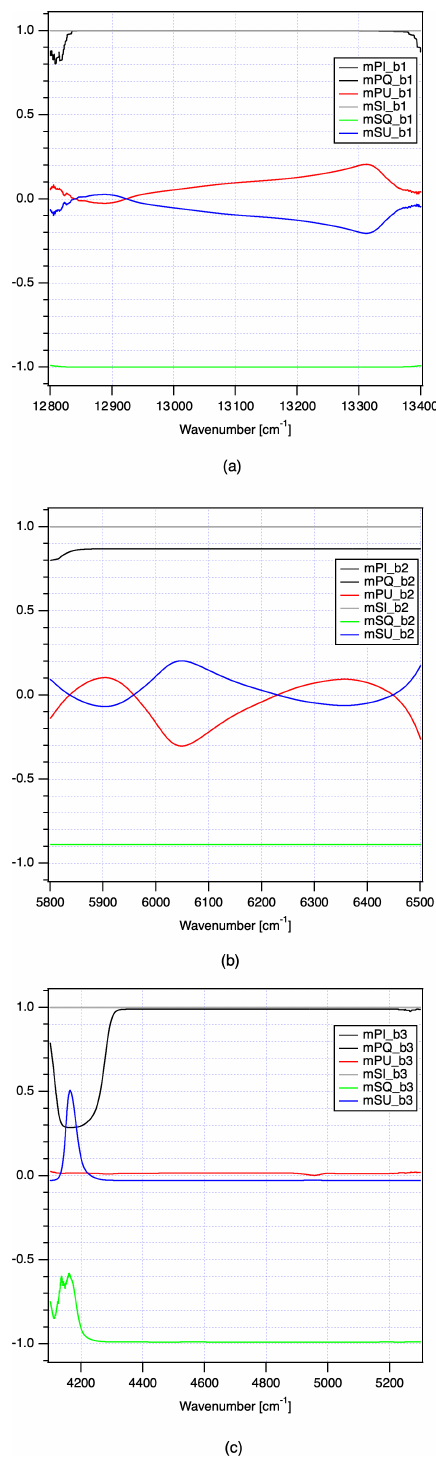
Figure 4. The estimated Mueller matrix coefficients against I , Q , and U components: (a) band 1, (b) band 2, and (c) band